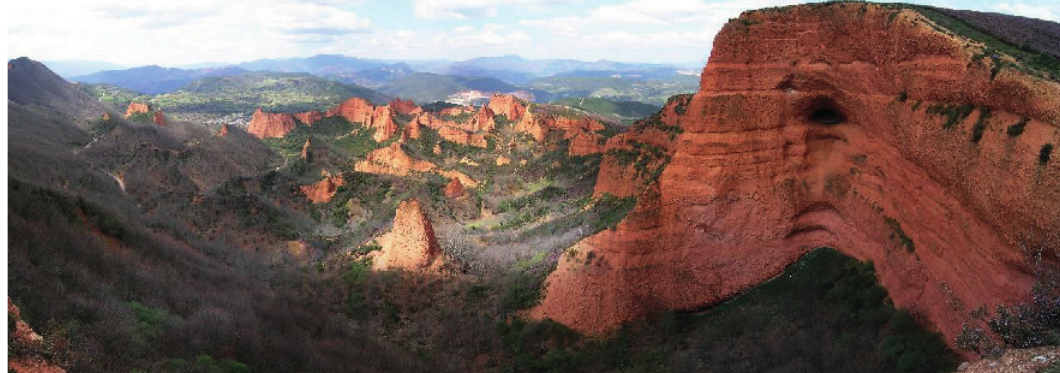
FIGURE 3 . Class 2 Geo-mining heritage. Anthropogenic geoforms from Las Médulas (Spain), an ancient gold mine from the Roman period, active throughout the 1 st and 2 nd century AD (photo Alessio